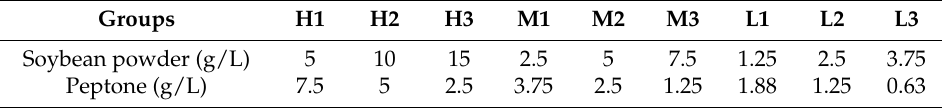
Table 2. Nitrogen concentration and proportion of soybean powder and peptone in nitrogen limitation